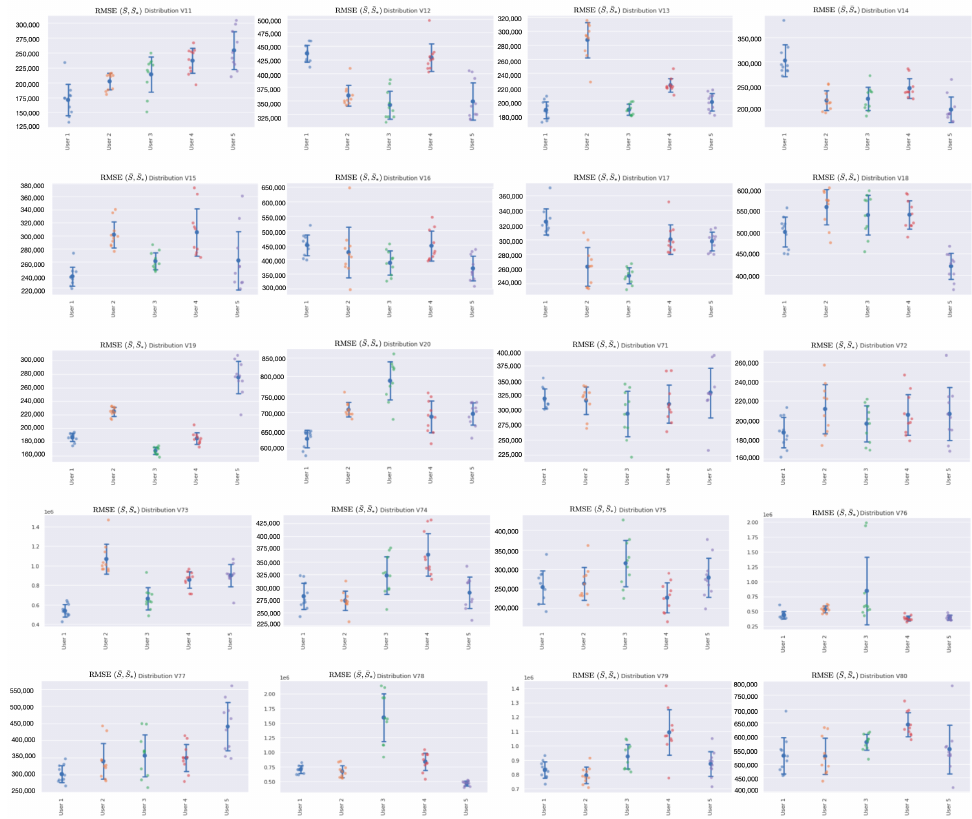
Figure 7. Error bar plot with mean and standard deviation for each human-annotated summary of the subset of 20 videos from [1]. Sampling rate: 1 frame per